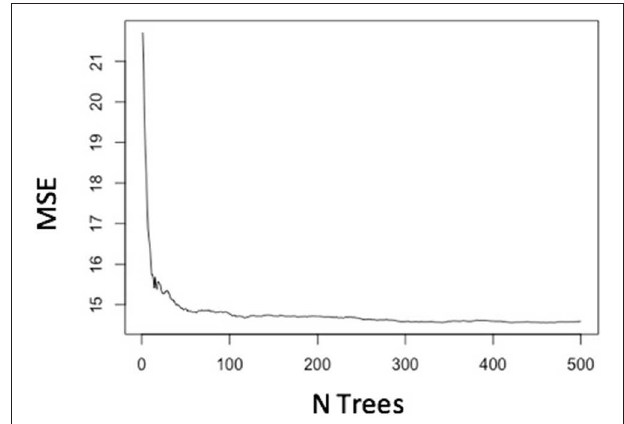
FIGURE 1 | Mean square error (MSE) plotted against the number of trees in the random